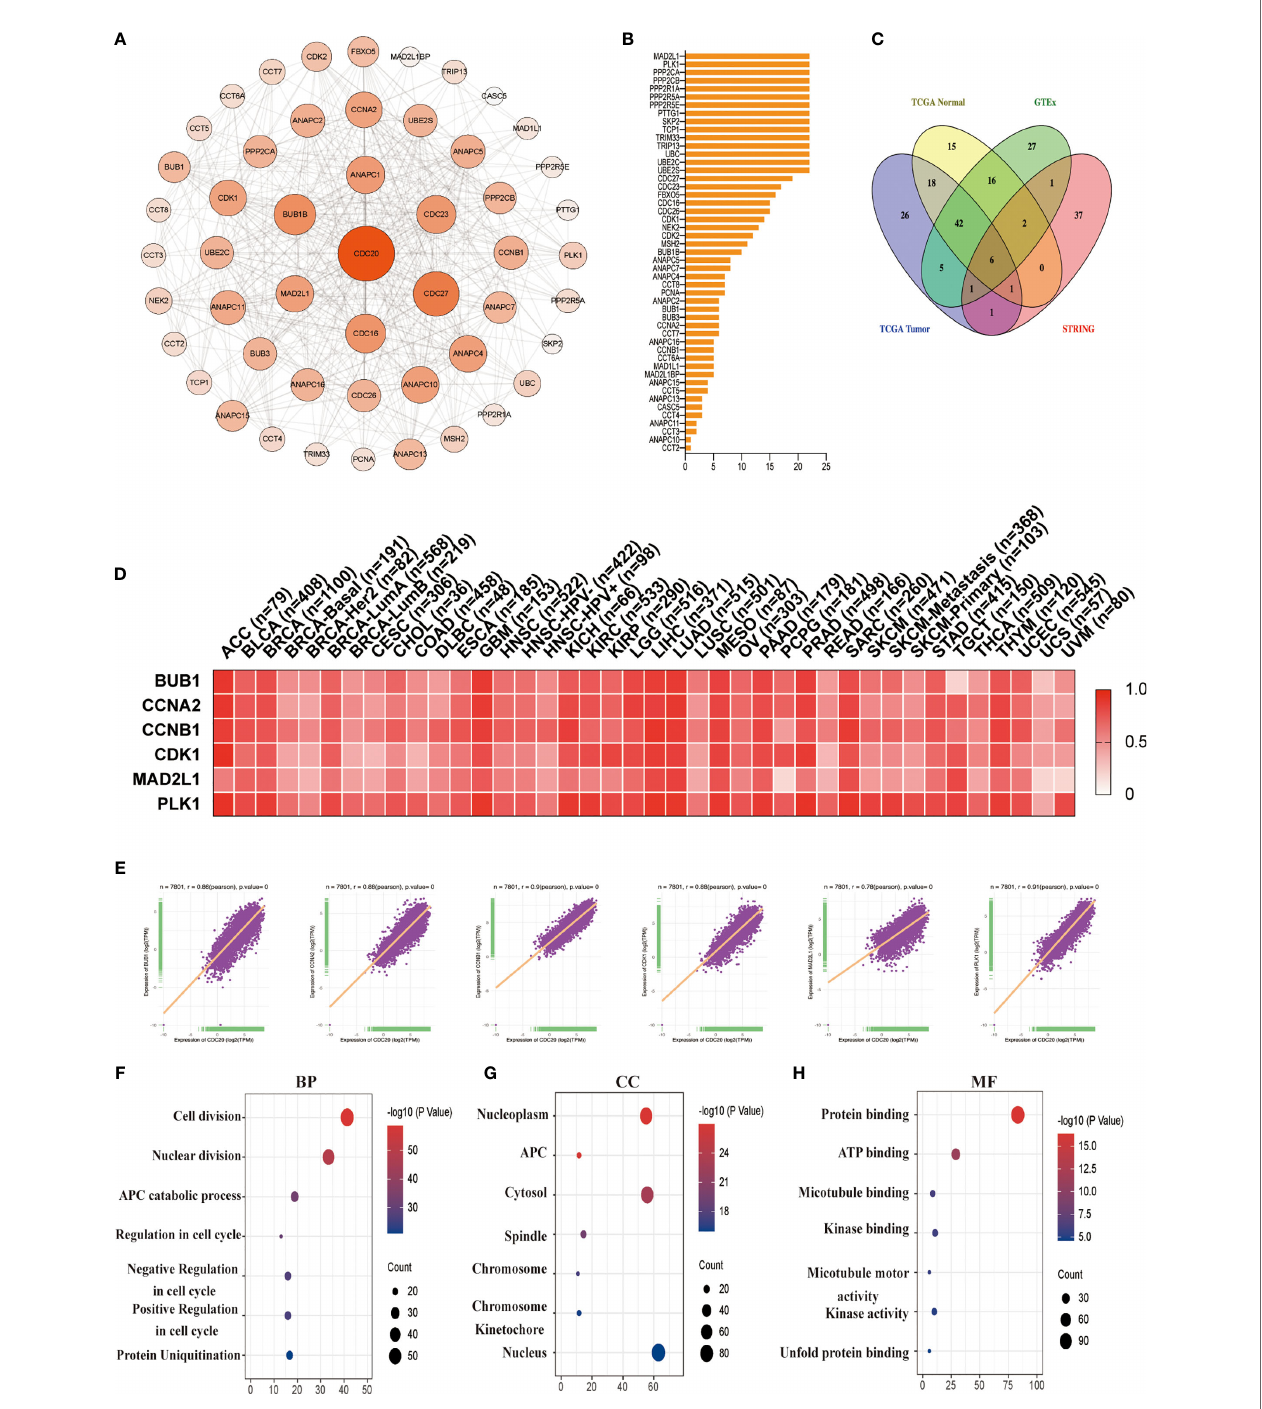
FIGURE 6 | CDC20 -related gene enrichment analysis. (A) The interaction network of Cdc20-binding proteins according to experimental evidence using the STRING tool is displayed. (B) The names and number of interaction nodes of the Cdc20-binding proteins according to experimental evidence using the STRING tool are displayed. (C) The Venn Diagram of the top 100 CDC20 -correlated genes in TCGA tumor tissues, normal tissues, and GTEx database, as well as the gene encoding Cdc20-binding proteins according to experimental evidence using the STRING tool is displayed. (D) The corresponding heatmap of the intersection genes ( BUB1, CCNA2, CCNB1, CDK1, MAD2L1, PLK1 ) in the detailed cancer types are displayed. (E) A pan-cancer correlation analysis of the CDC20 mRNA levels and the top 6 correlated genes ( BUB1, CCNA2, CCNB1, CDK1, MAD2L1, PLK1 ) was conducted. (F – H) Based on the Cdc20-binding and interacted genes, the dot plot for the molecular function data in GO analysis is